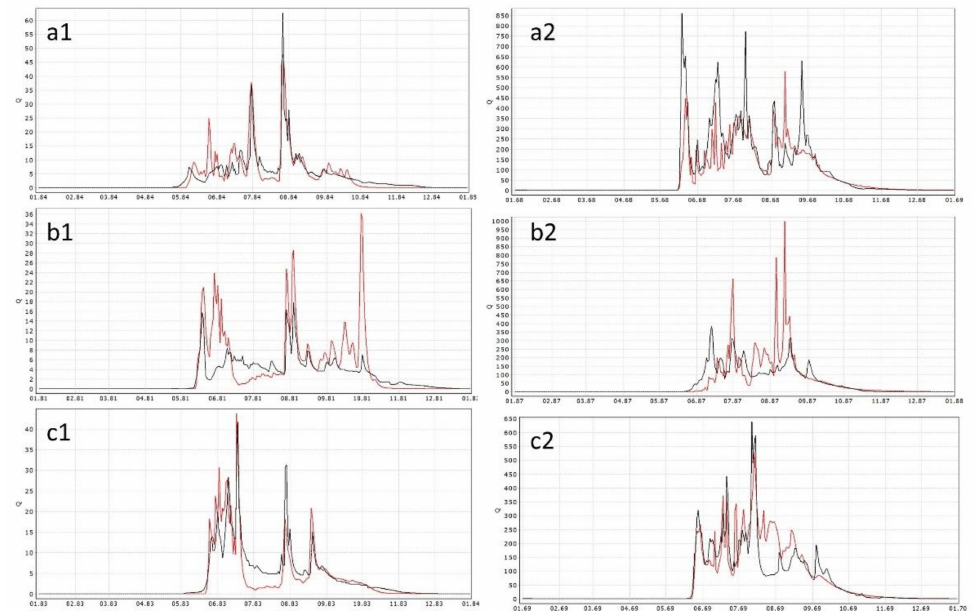
Figure 5. Observed (black) and simulated (red) streamflow hydrographs; 1 —Anmangynda, 2 — Charky; ( a – c )—high, low and average NS